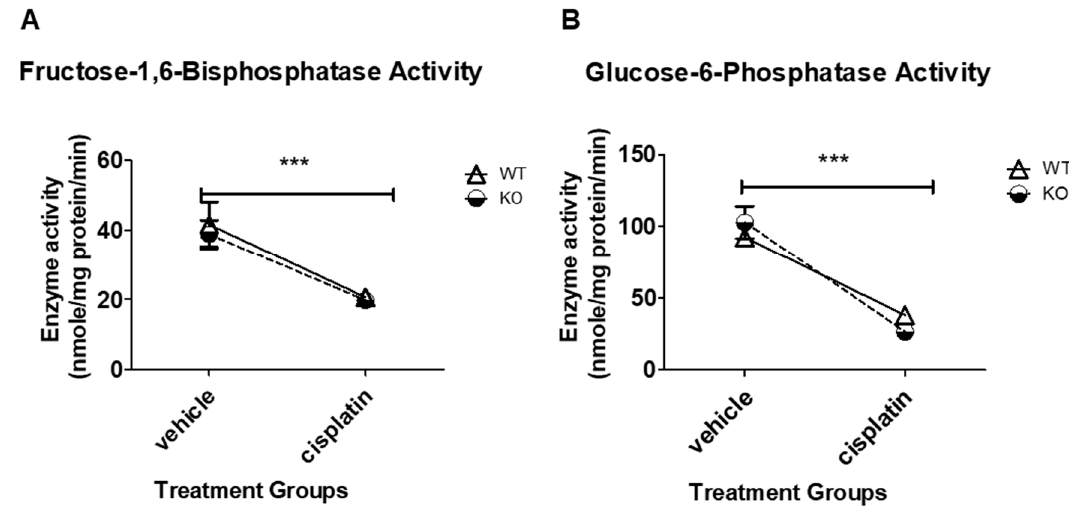
Figure 1. Effect of cisplatin treatment on fructose-1,6-bisphosphatase and glucose-6-phosphase enzyme activity in wild-type (WT) and Na/H exchange regulatory factor 1 (NHERF1) knockout (KO) mouse kidneys. Two to 4-month-old male C57BL/6J WT and NHERF1 KO mice were given cisplatin (20 mg/kg dose intraperitoneally (IP)) or vehicle (saline) and sacrificed after 72 h as described in the Methods section. ( A ) Fructose-1,6-bisphosphatase (FBPase) enzyme activity was determined from the